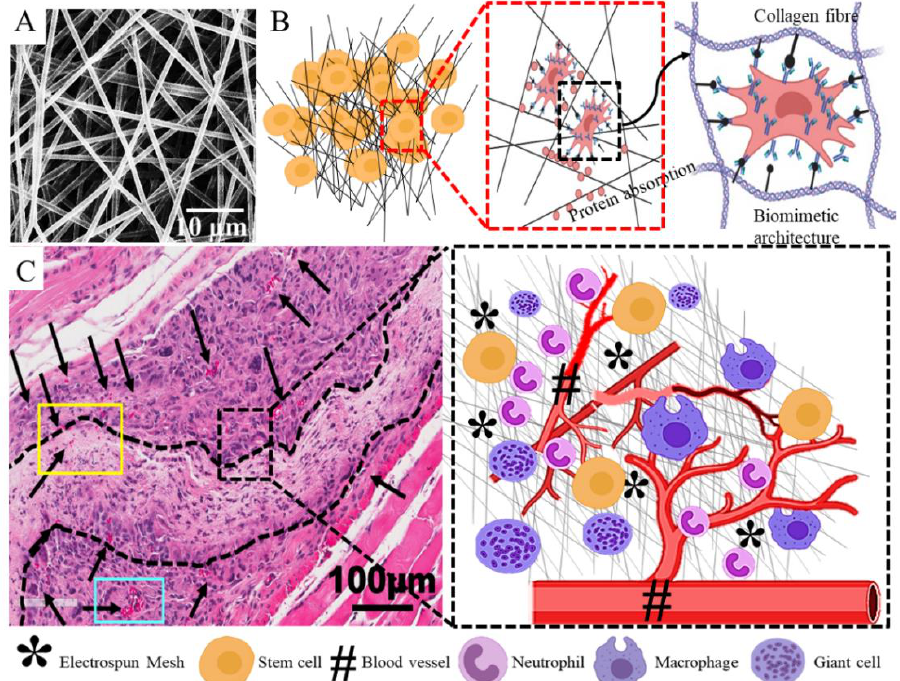
Figure 11. Tissue engineering attributes of electrospun nanofiber mesh showing nanofiber mesh ( A ), cell seeding and interaction with nano scale feature ( B ), tissue integration without formation of fibrous capsule and host response toward tissue healing ( C ). Reproduced with permission of [77]. Reproduced with permission of [78]. Copyright AAAS, 2005.